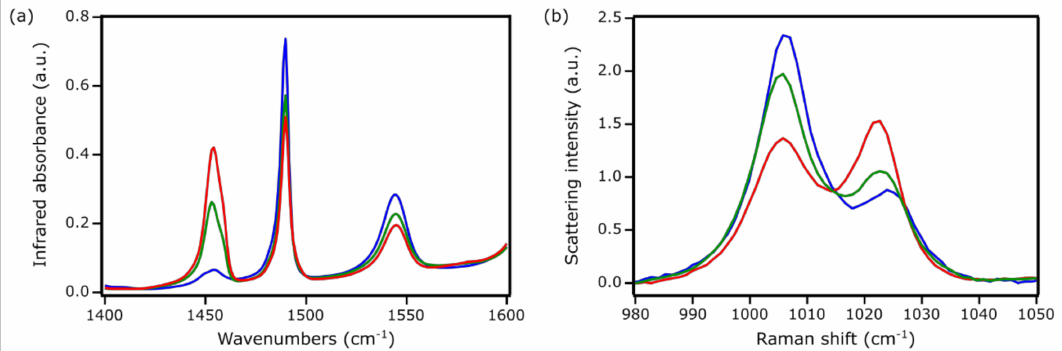
Figure 1. ( a ) FTIR and ( b ) spontaneous Raman spectra of pyridine chemisorbed in ZSM-5 zeolites after desorption at 150 ◦ C under vacuum (blue: Zn000, green: Zn030, red: Zn600). The FTIR and Raman spectra were acquired at 150 ◦ C under vacuum and in ambient conditions,